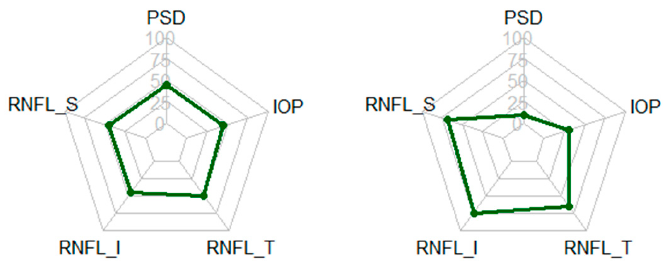
Figure 4. Radar charts for typical glaucoma and healthy patients.